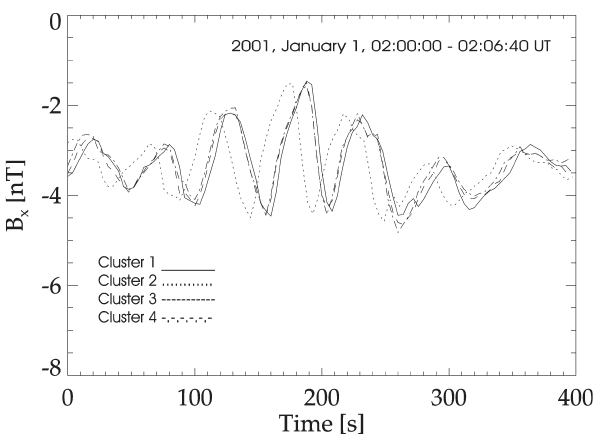
Fig. 7. Magnetic field measurements of the B X component made at the four Cluster spacecraft in the time interval on 1 January 2001, 02:00–02:06 UT.